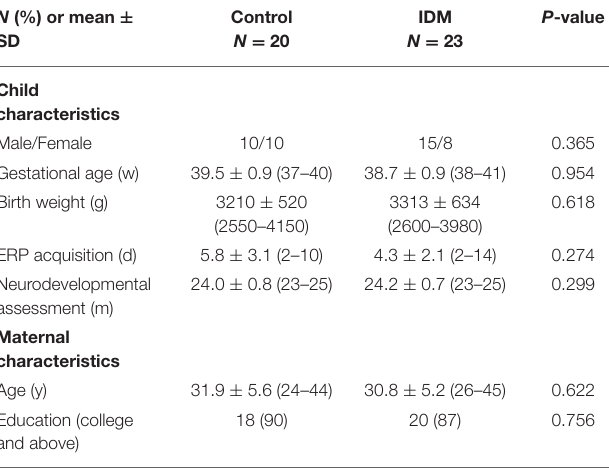
TABLE 1 | Participant demographics. TABLE 2 | Comparison of MMR amplitudes produced by two groups at different electrode positions and with different emotional prosodies ( ± S, µ